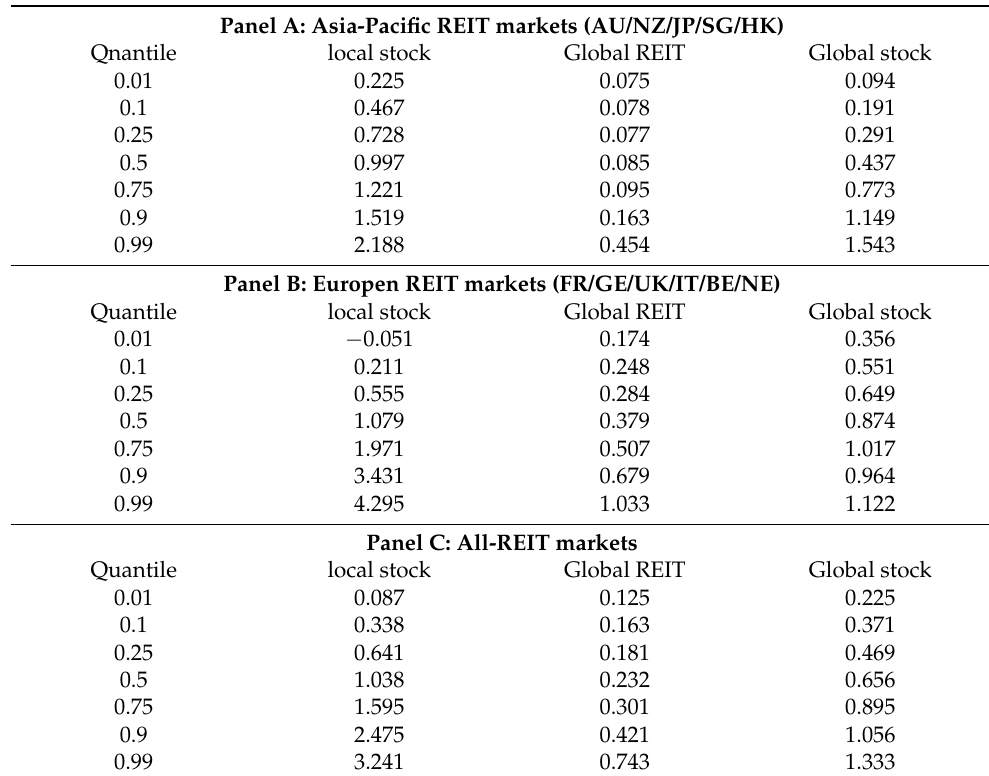
Table 5. Overall and regional (Asia-Pacific and European) REIT market interdependence levels with local stocks, global REITs, and global